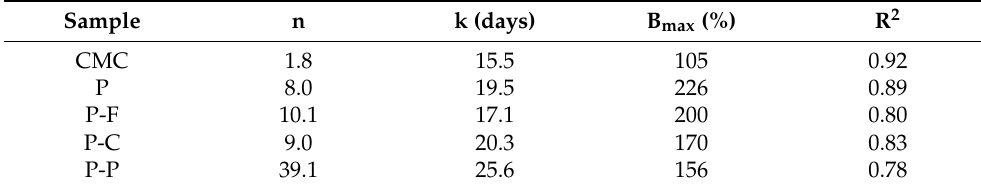
Table 4. Hill’s parameters (%B max , k and n) for the different films and cellulose microcrystalline (CMC, reference). k: time needed to reach 50% of B max , and B max : percentage of biodegradation at infinite time. Sample n k (days) B max (%) R 2 CMC 1.8 15.5 105 0.92 P 8.0 19.5 226 0.89 P-F 10.1 17.1 200 0.80 P-C 9.0 20.3 170 0.83 39.1 25.6 156